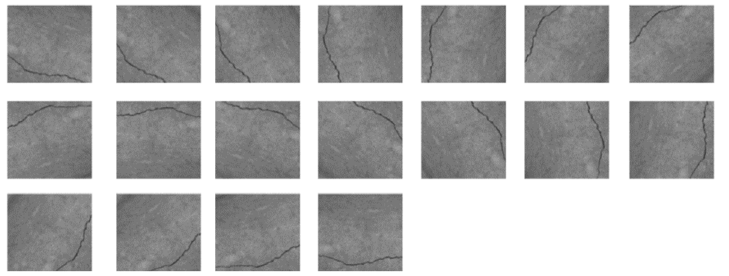
Figure 12. After the same proportional scaling, the 360-degree rotation in the same patch is augmented.